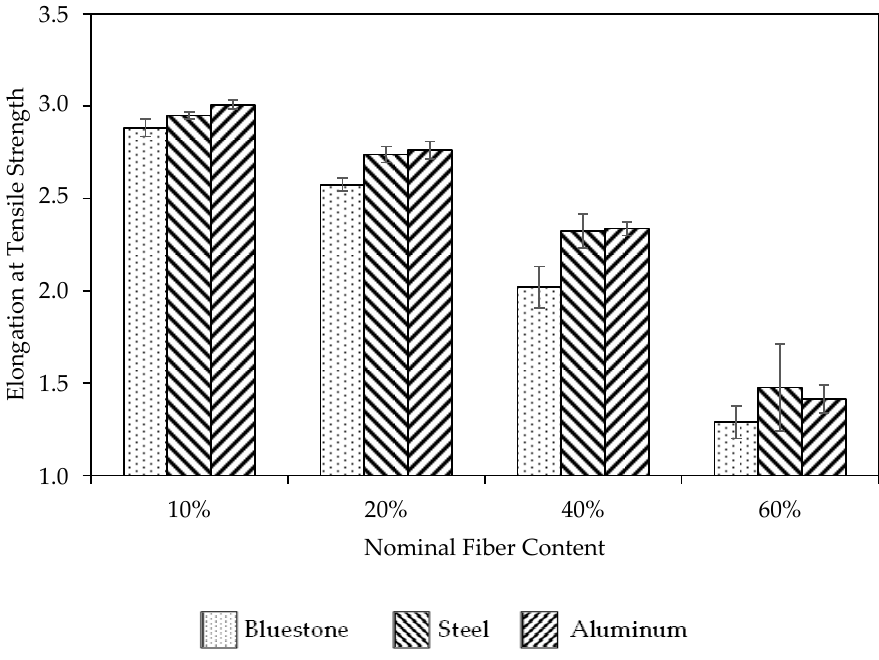
Figure 16. Elongation at tensile strength for tensile specimens from Bluestone, steel, and aluminum tools for nominal fiber contents of 10 wt.%, 20 wt.%, 40 wt.%, and 60 wt.%.